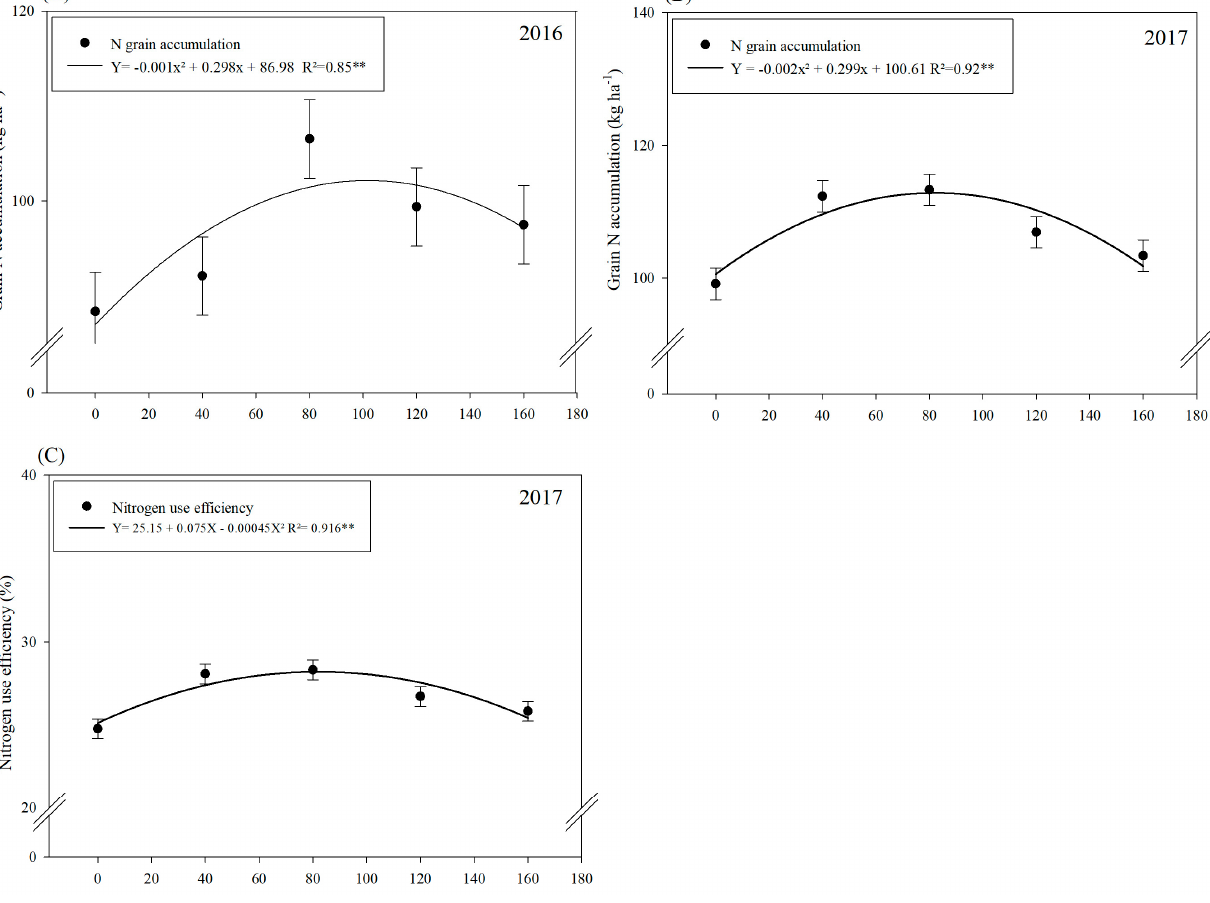
Figure 1. Grain N accumulation in 2016 ( A ) and 2017 ( B ); nitrogen use efficiency (NUE) in 2017 ( C ); NUE in 2016 was not significant as a function of N doses and plant growth-promoting bacterial inoculations and co-inoculation. Error bars indicate the standard deviation of the means ( n = 4 replications). **: means it is statistically significant by Tukey’s test at probability p ≤ 0.01.